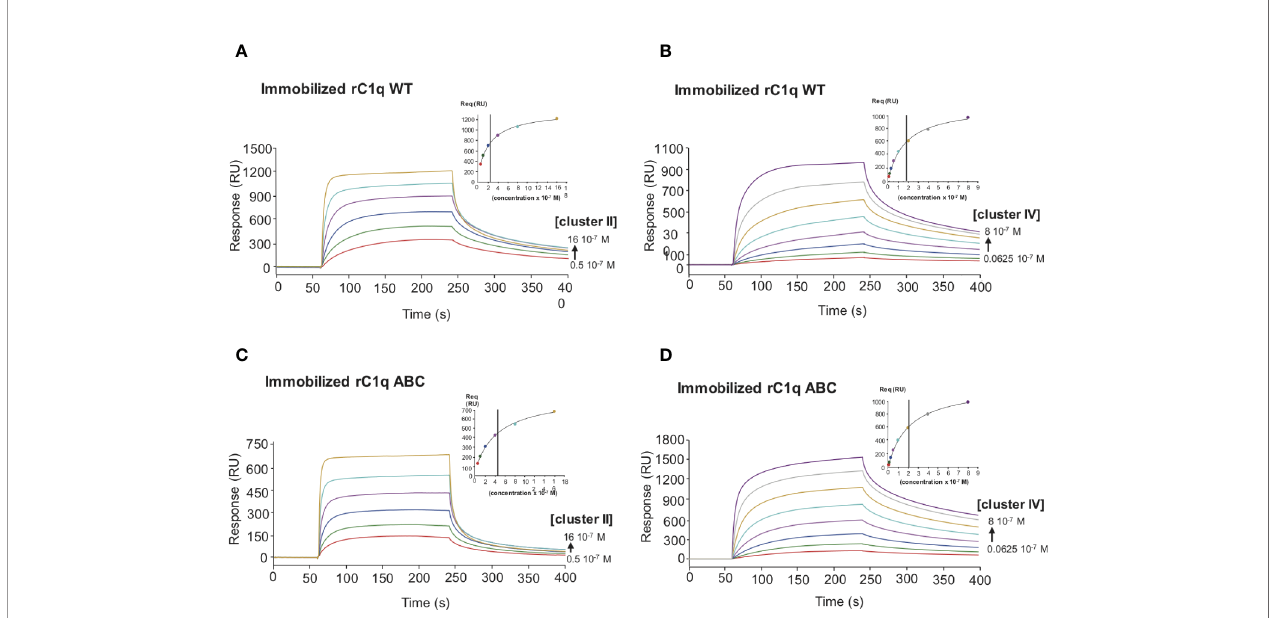
FIGURE 7 | Comparative kinetic analysis of the interaction of LRP1 clusters II and IV with immobilized recombinant C1q variants. LRP1 clusters II (left panels) and IV (right panels) were injected at indicated concentrations over immobilized recombinant C1q (rC1q WT, 11,000 RU, A , B panels) or C1q mutant LysA59Ala/LysB61Ala/ LysC58Ala (rC1q ABC, 12,300 RU, C , D panels) in 50 mM Tris, 150 mM NaCl, 2 mM CaCl 2 , 0.05% P20, pH 7.4. The Req versus concentration plots of steady state fi ttings are shown on the top right of the SPR curves. K D values (means ± SD) for each kinetics are summarized in Table 2